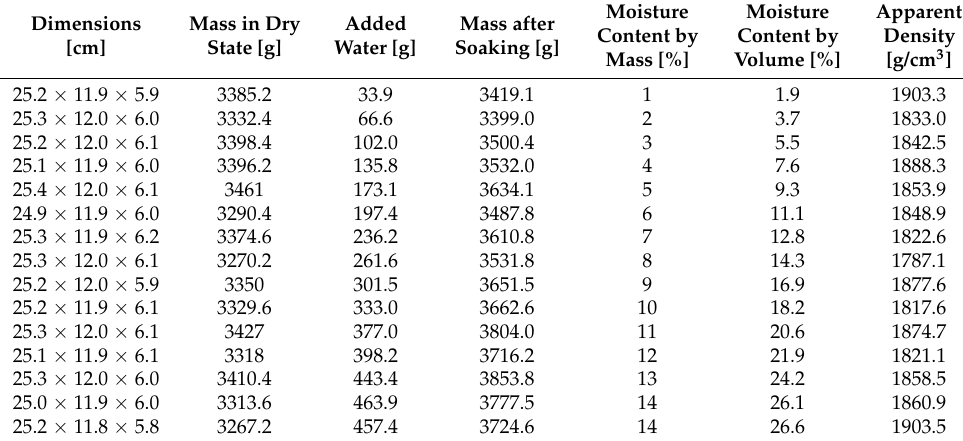
Table 1. Parameters of solid ceramic bricks adopted for testing.